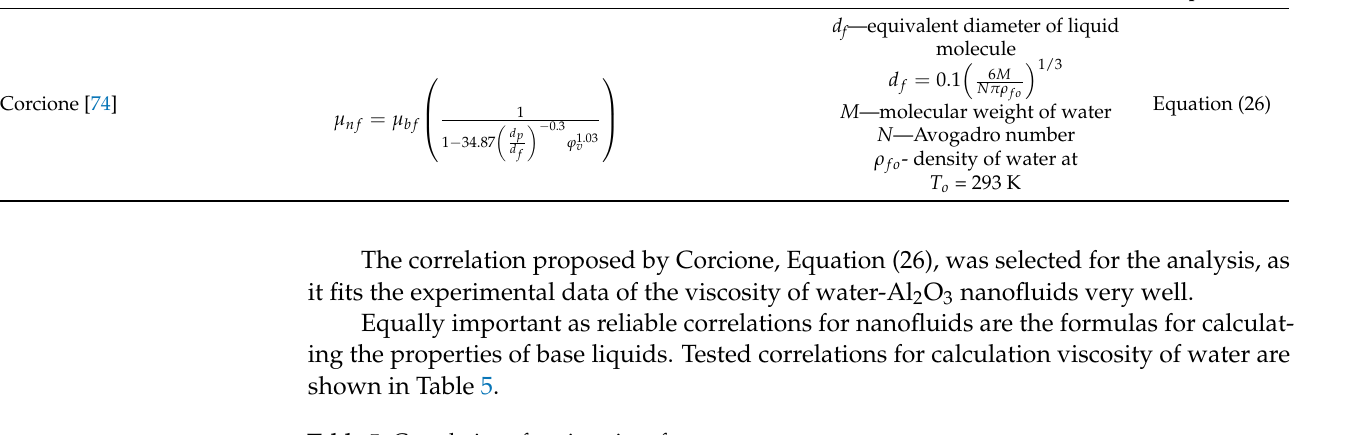
Table 5. Correlations for viscosity of water.